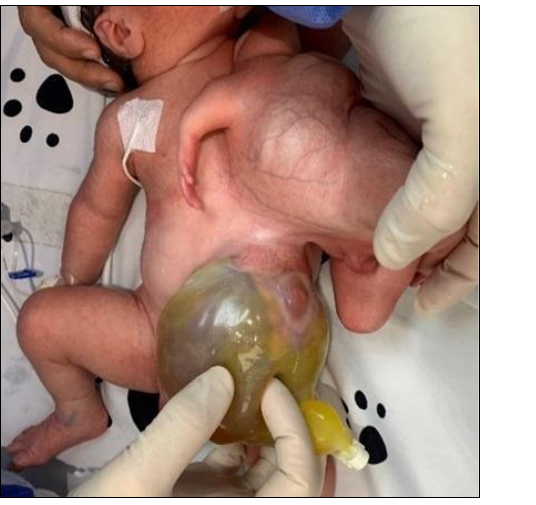
Figure 1: HT with omphalocele